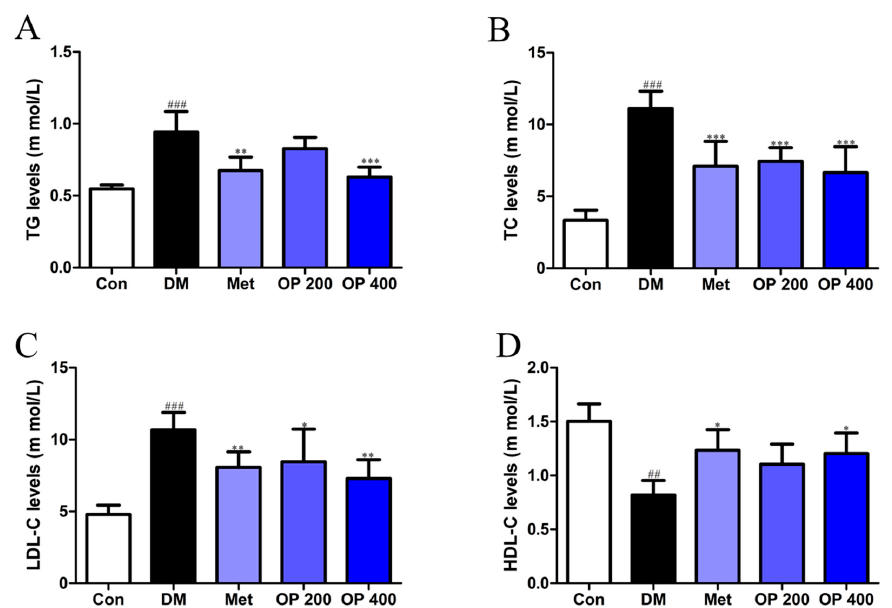
Figure 5. E ff ects of OP on ( A ) serum triglyceride (TG), ( B ) total cholesterol (TC), ( C ) low density Figure 5. Effects of OP on (A) serum triglyceride (TG), (B) total cholesterol (TC), (C) low density lipoprotein cholesterol (LDL-C), and ( D ) high-density lipoprotein cholesterol (HDL-C) of experimental lipoprotein cholesterol (LDL-C), and (D) high-density lipoprotein cholesterol (HDL-C) of mice. Data represent means ± SEM (n = 10). ## p < 0.01, ### p < 0.001 vs. control, * p < 0.05, experimental mice. Data represent means ± SEM (n = 10). ## p < 0.01, ### p < 0.001 vs control, * p < 0.05, ** p ** p < 0.01,*** p < 0.001 vs. model. < 0.01, *** p < 0.001 vs model.